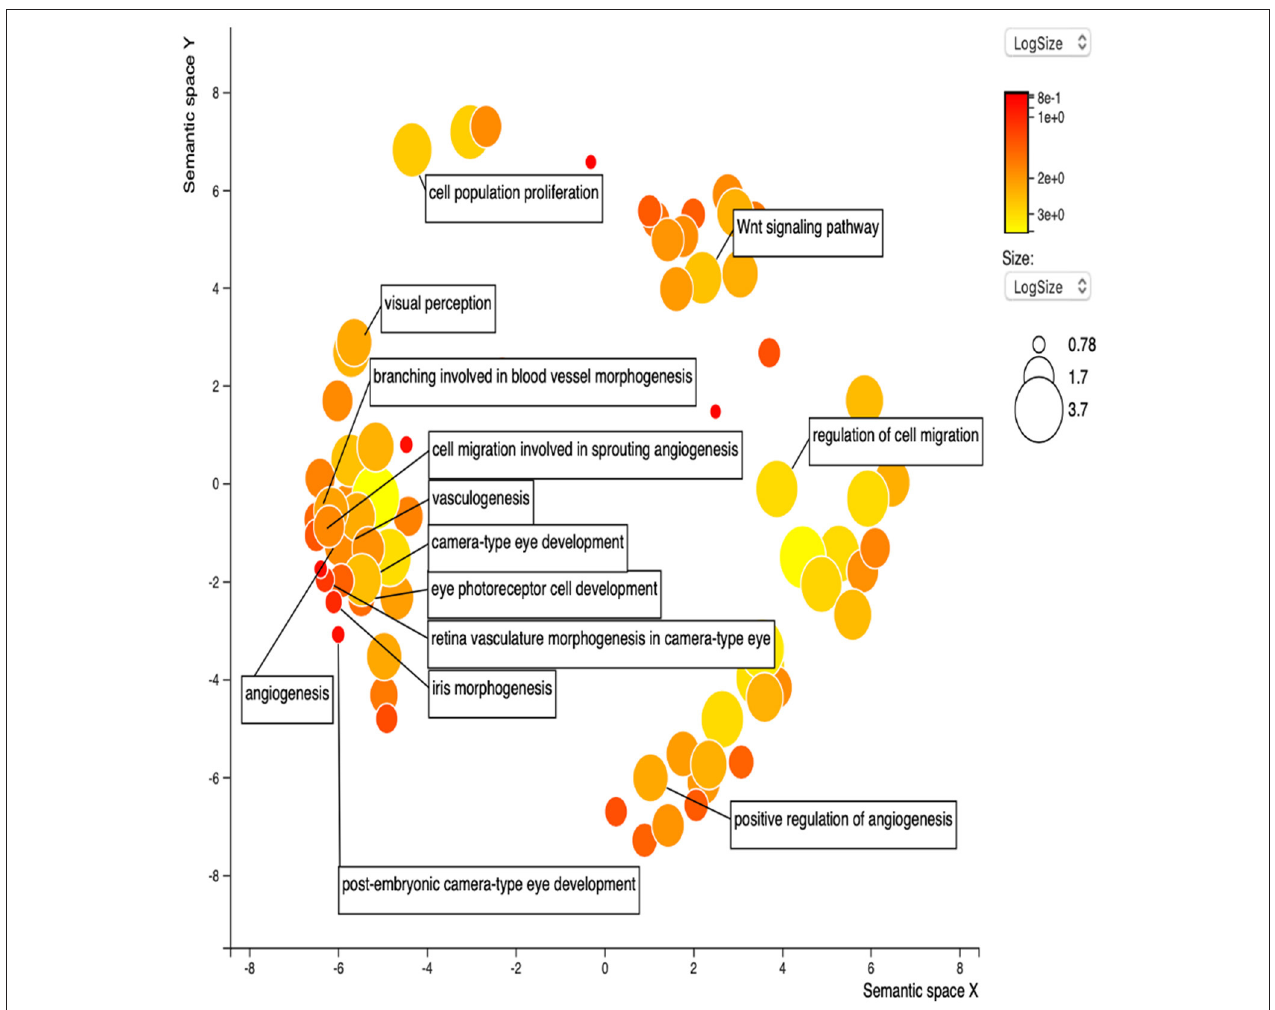
FIGURE 5 | Gene Ontology terms of the 14 hub genes. The figure represents enriched GO terms related to eye morphogenesis and vasculature remodeling. DAVID and the REVIGO web server were employed to conduct functional and pathway enrichment